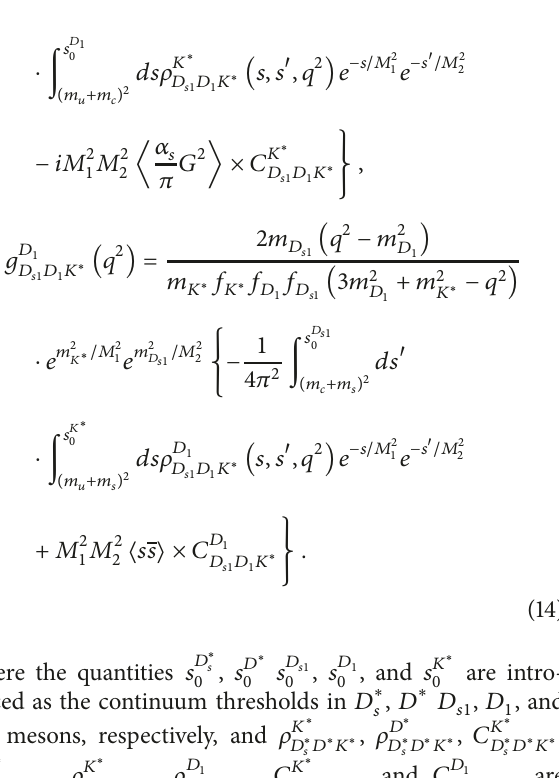
Figure 3: Nonperturbative diagrams for the off-shell 𝐾 ∗